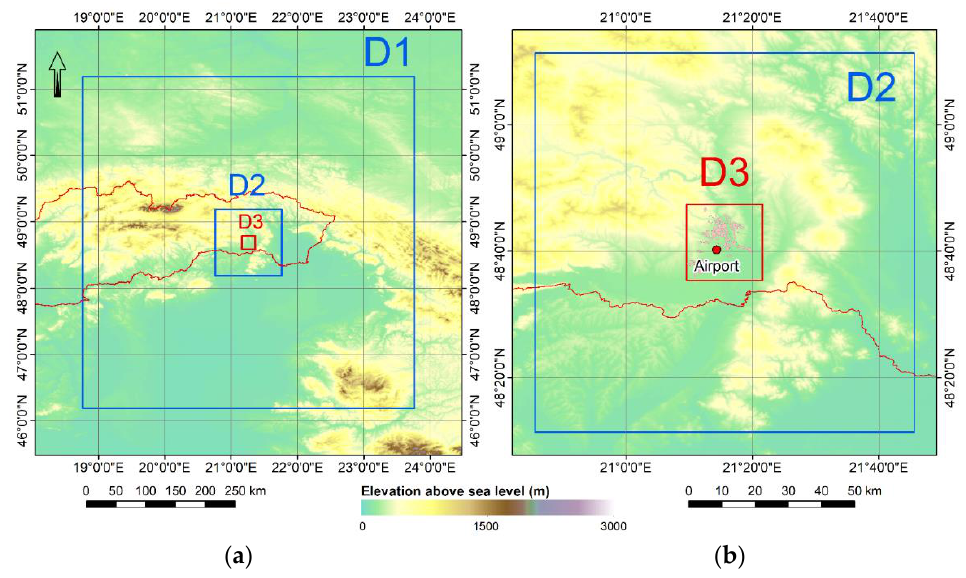
Figure 1. Position of model domains ( a ) and urban area of Košice with airport ( b ).